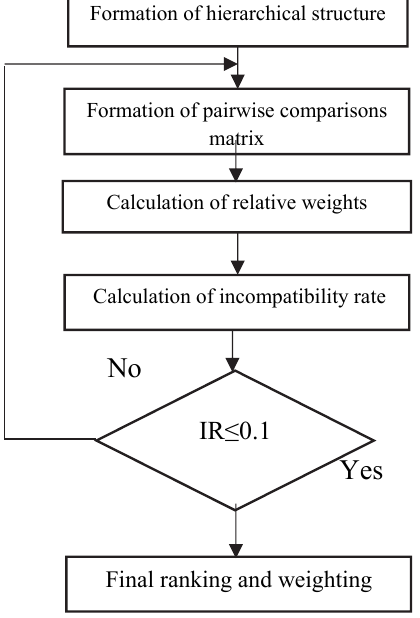
Formation of hierarchical structure